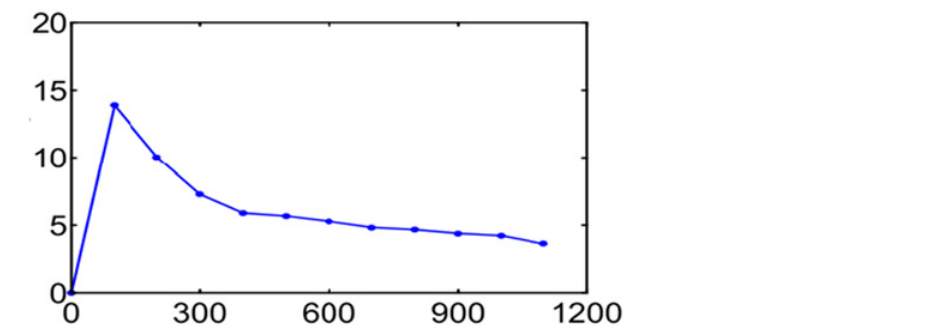
Fig 3. Length distribution of the predicted longest ORF.